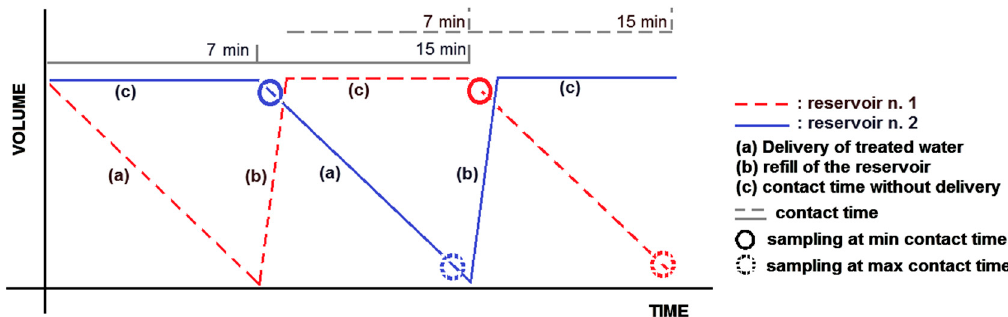
Figure 3. Delivery of treated water from the W.H.E. device.